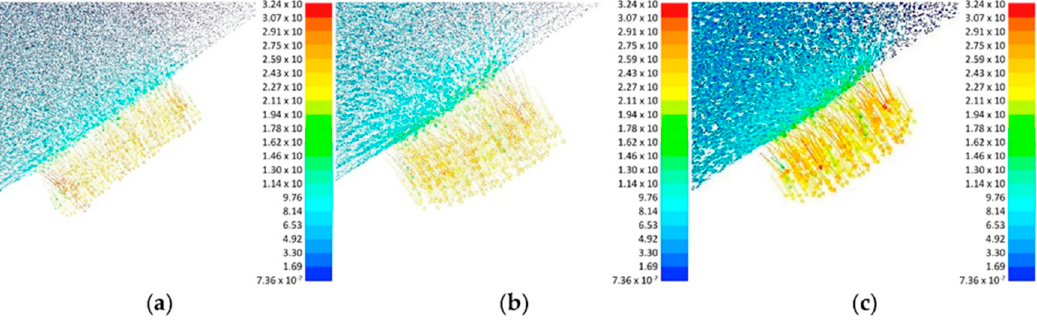
Figure 7. Velocity field for longitudinal orifice at P = 5.0 bar and Qin = ( a ) 10 L/s, ( b ) 20 L/s, ( c ) 30 L/s [17].